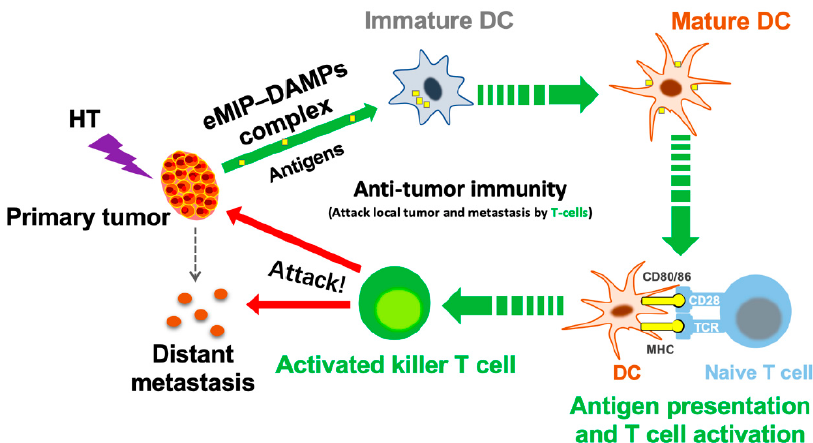
Figure 3. A possible mechanism of action of the present combination therapy. DAMPs, such as HSP70 and HMGB1 are released from HT-treated tumor cells, which form a complex with intravenously administered eMIP. The complex activates dendritic cells followed by T cell activation. Finally, activated killer T cells attack tumors at the treated site and at distant metastases.